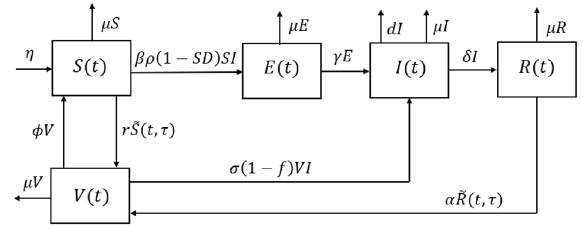
Figure 1. Flowchart of the